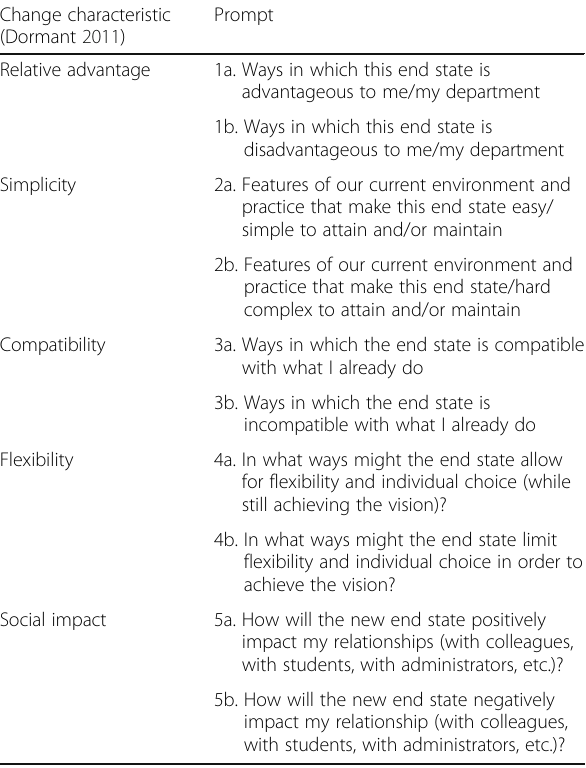
Table 1 Change protocol meeting